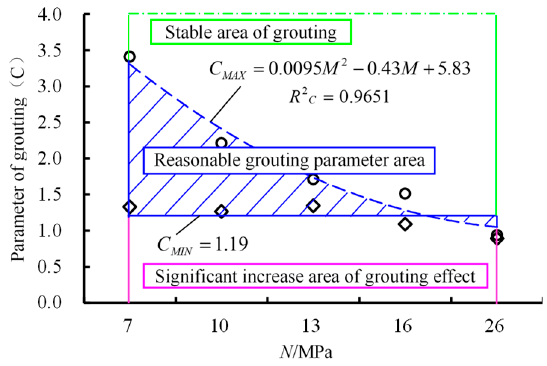
Figure 14. Characteristics of reasonable grouting strength.